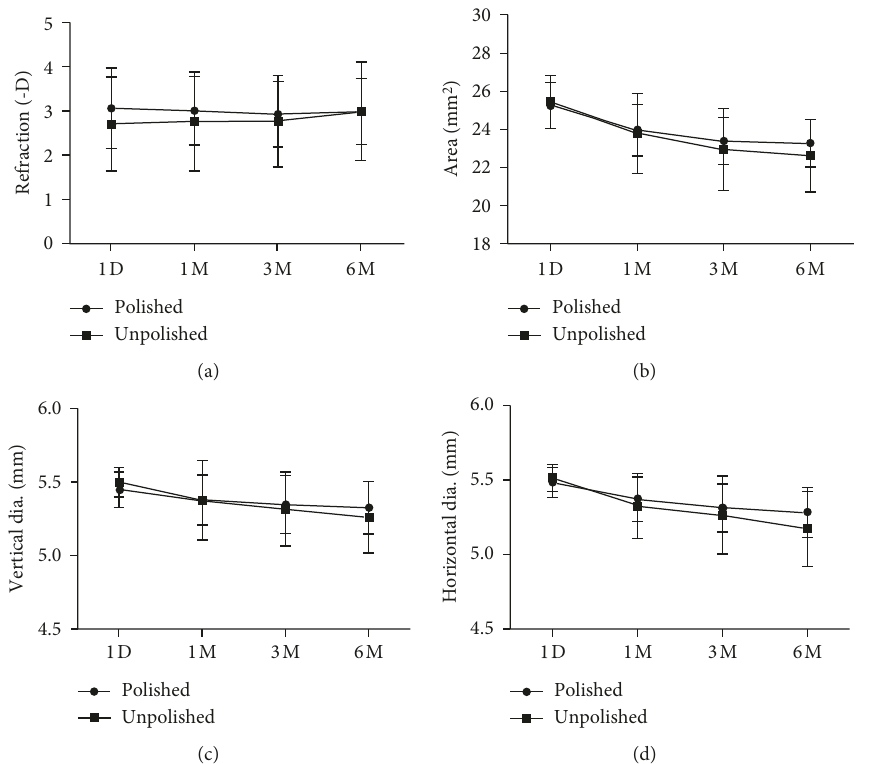
Figure 3: The differences in refraction and anterior capsule opening size between the two